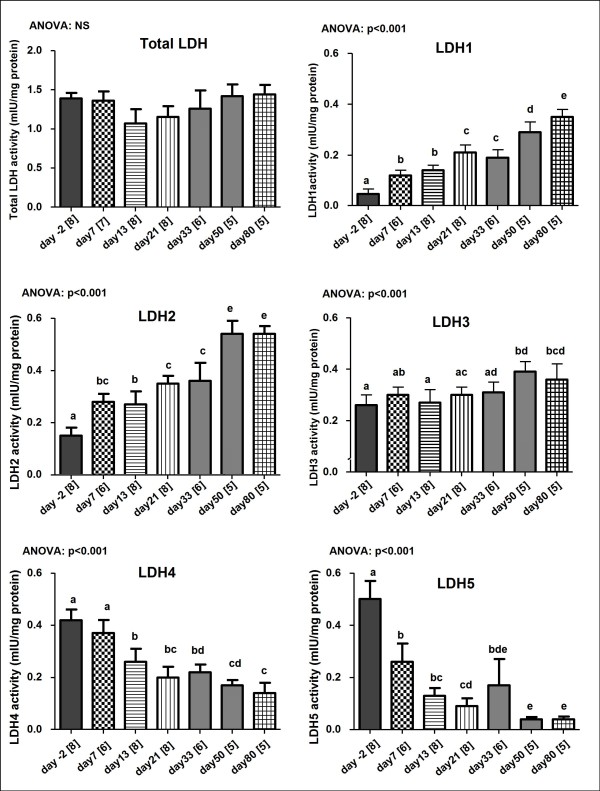
Total lactate dehydrogenase (LDH) and its isoenzyme activities during maturation. Values are means ± S.E. and sample size are given in brackets on the labels of the X axis. Data points with different superscript letters are significantly different to all other timepoints (p < 0.05, LDH1, LDH2, LDH3, LDH4: Bonferroni; LDH5: Dunnett T3, ANOVA "test for linear trend": as indicated).Note: NS = not significant, p > 0.05